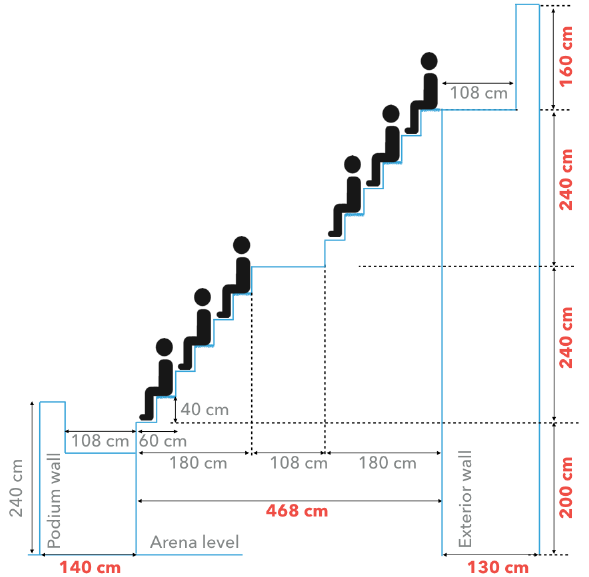
Figure 5. Hypothetical inclination of the